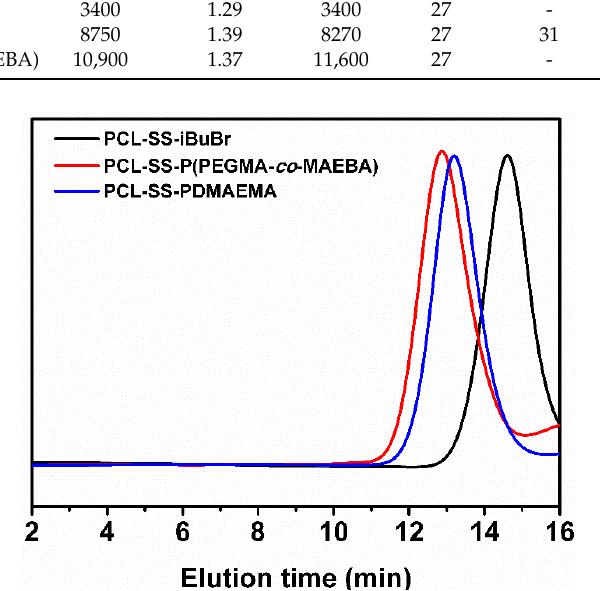
Figure 3. GPC (Gel Permeation Chromatography) traces of PCL-SS-P(OEGMA- co -MAEBA) and PCL-SS-PDMAEMA. Table 1. 1 H NMR and GPC data of the copolymers PCL-SS-PDMAEMA, PCL-SS-P(PEGMA- co - MAEBA) and their precursor PCL-SS-iBuBr.